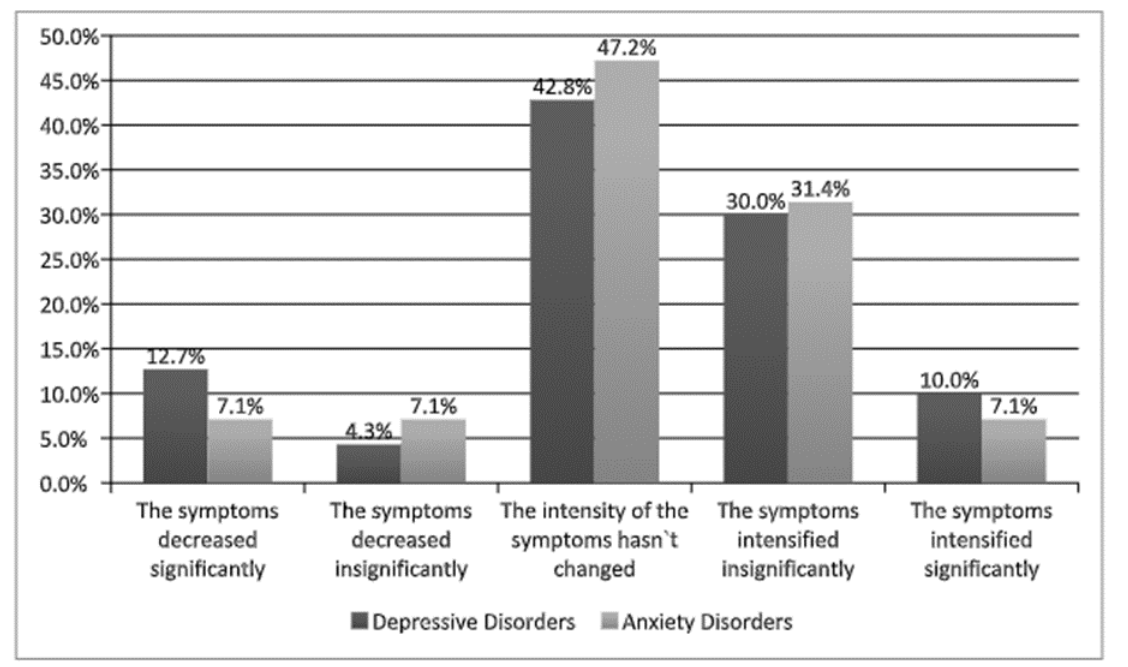
Figure 1. The intensity of symptoms in individuals diagnosed with depression or anxiety disorders during the COVID-19 pandemic. Table 2. Concerns in each